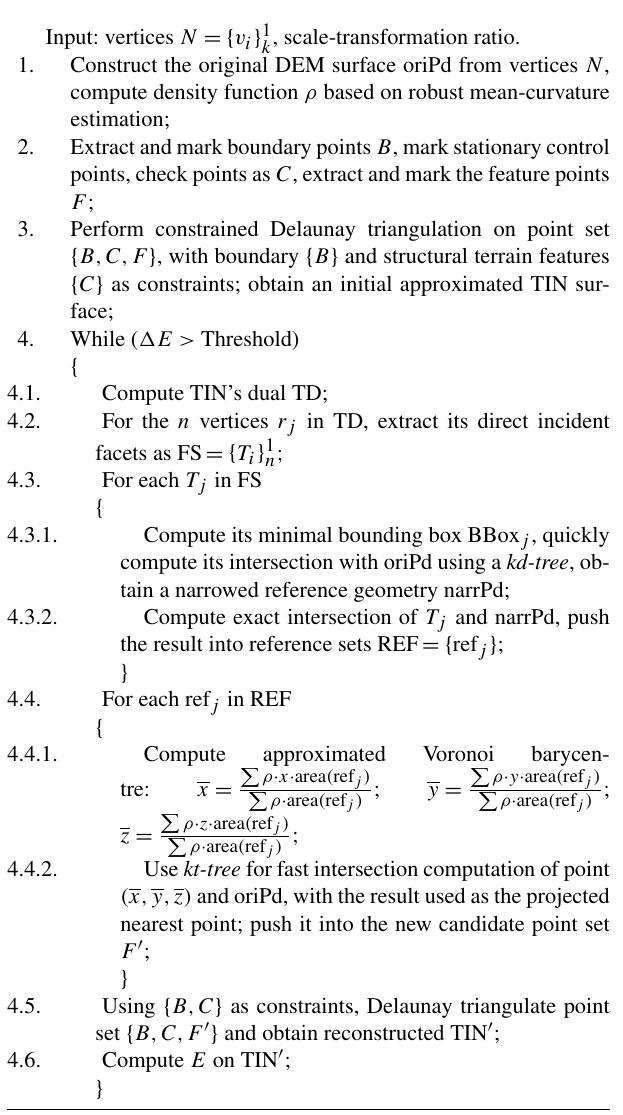
Algorithm 2 cCVT_iteration